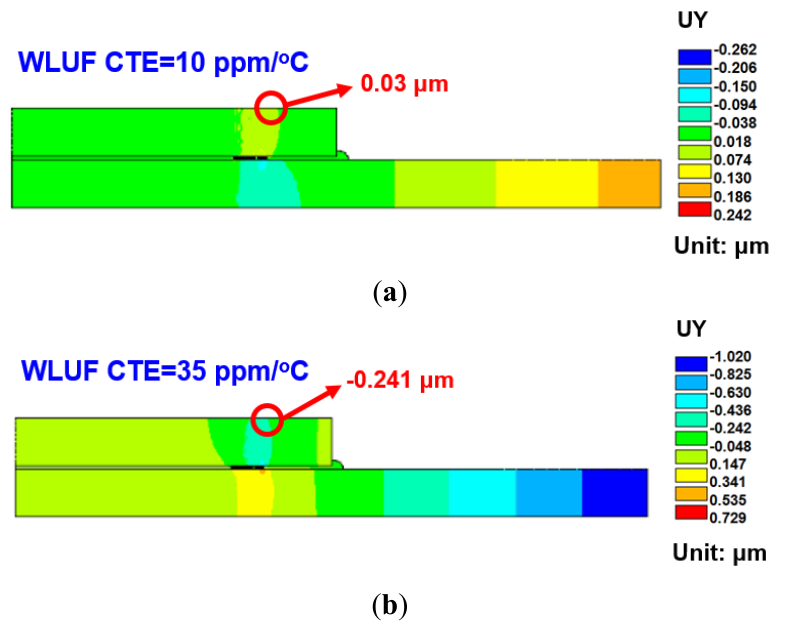
Figure 15. Warpage contour for a deformed/undeformed packaging vehicle with different CTE of WLUF when stacked chip and silicon substrate have same thickness of 385 μ m: ( a ) CTE = 10 ppm/°C; ( b ) CTE = 35